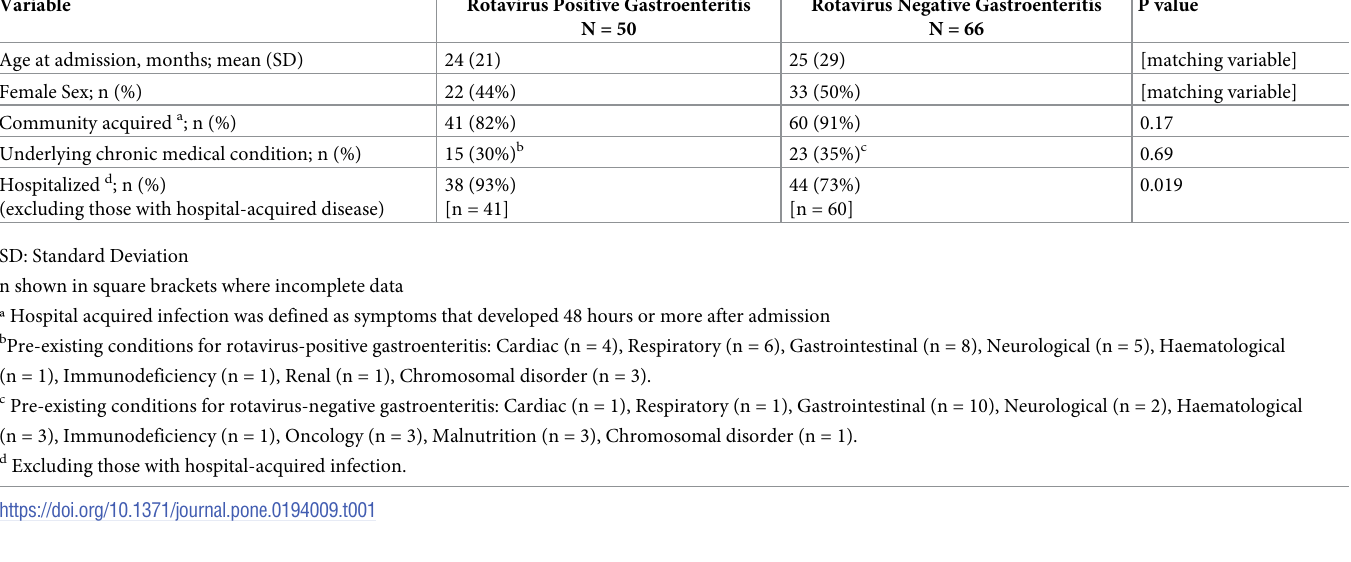
Table 1. Demographics of children with rotavirus-positive and rotavirus-negative gastroenteritis. Variable Rotavirus Positive Gastroenteritis